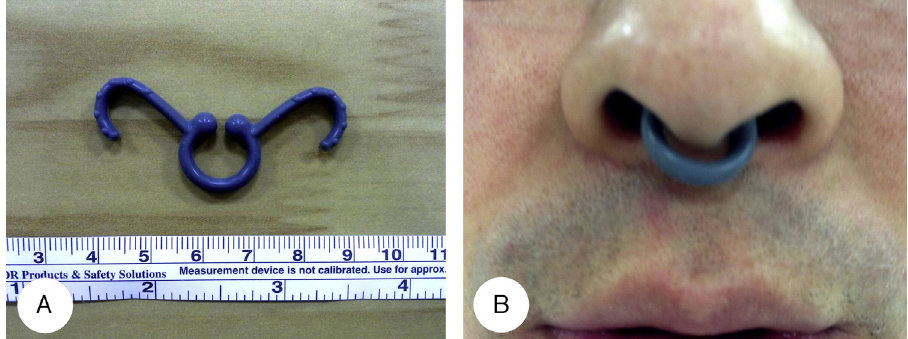
Figure 3 Nasal stent. (A) A wing-shaped stent has the inherent spring effect. (B) The stent placement provides a gentle pressure to the lateral nasal wall and septum, thus creating a tunnel in between. of the nasal vestibular stenosis, endoscopic examinations of the entire nasal cavity should be performed to rule out intranasal synechia. 4 A CT may be helpful to assess the thickness of atretic segment and any other associated abnor- mality of nasal cavity and sinuses. 1 In our case, nasal septum deviation and additional synechia were identified between the anterior aspect of inferior turbinate and nasal septum on both